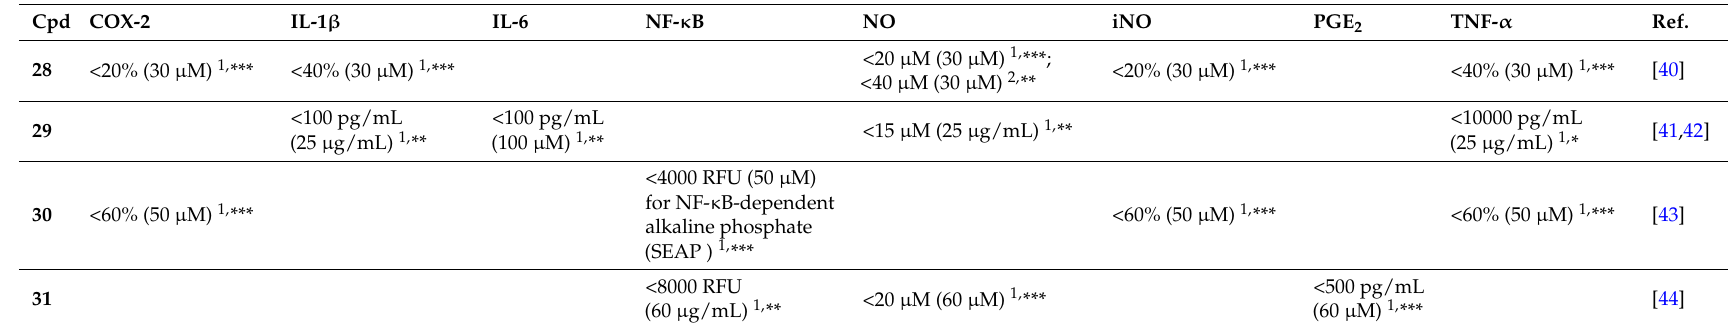
Table 3. Some anti-inflammatory activities of